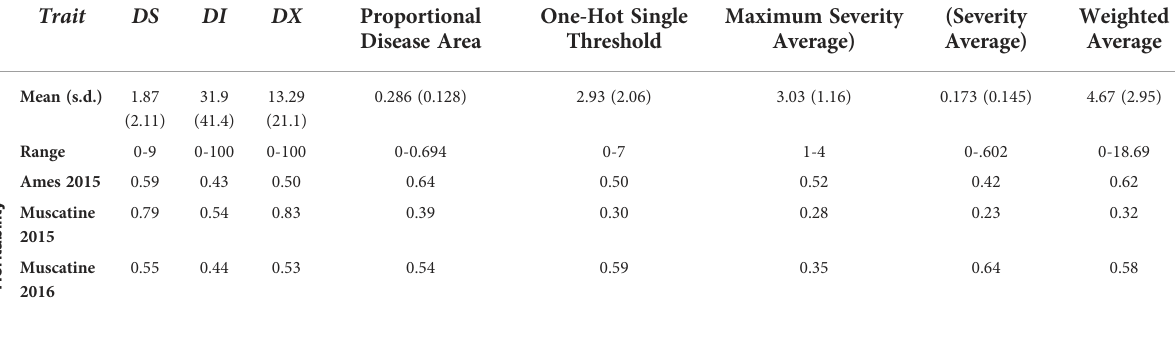
TABLE 3 Description of the distributions of each trait (mean, standard deviation, and range) and broad sense heritability within each environment. Trait DS DI DX Proportional